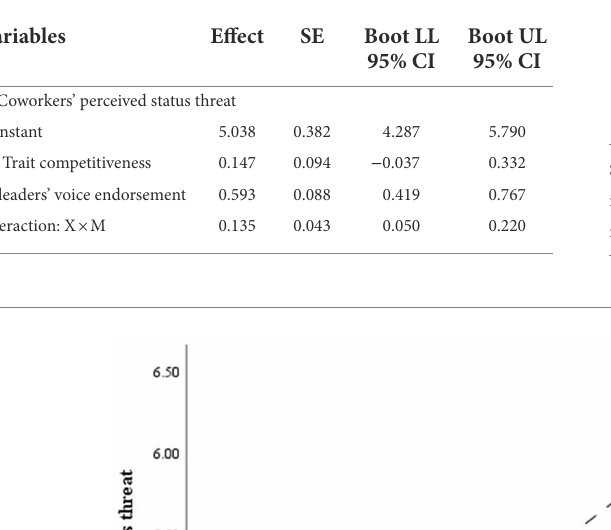
TABLE 4 Trait competitiveness as a moderator in the relationship between leaders’ voice endorsement and coworkers’ perceived status threat.